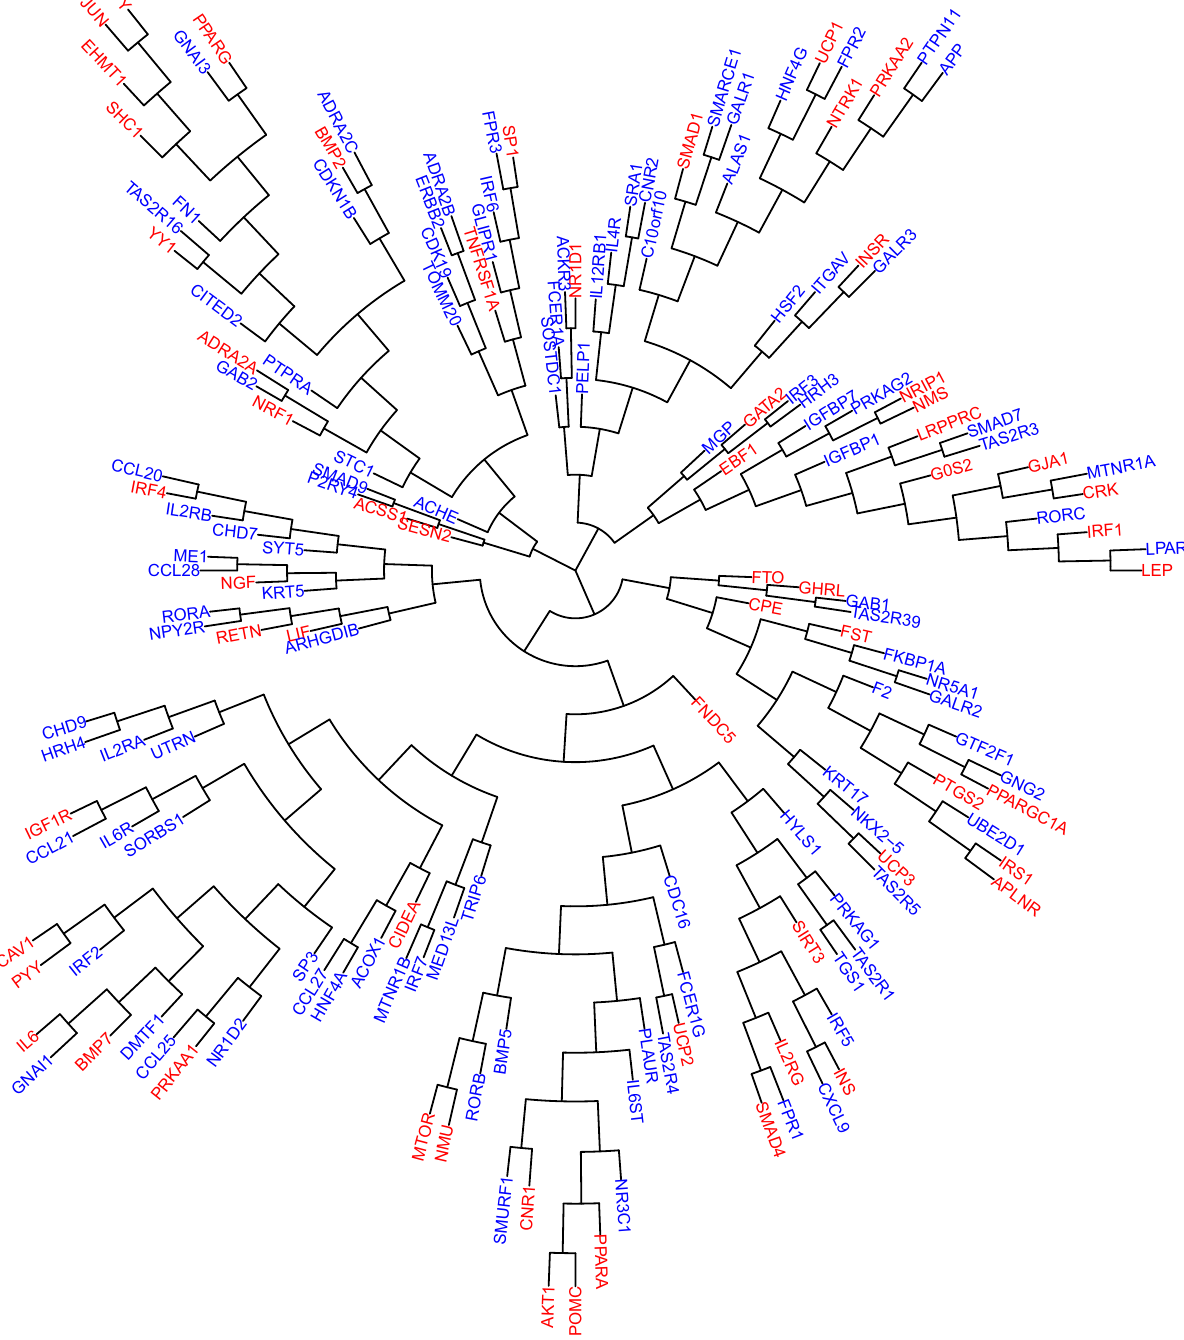
Figure 1. Functional genomic alignment phylogeny of brown adipose tissue (BAT) genes. A tree of biological distances generated by the functional genomic alignment method, showing hierarchical clustering of BAT genes. The genes related to BAT according to the literature search are shown in red, whilst predicted-novel candidate genes are shown in